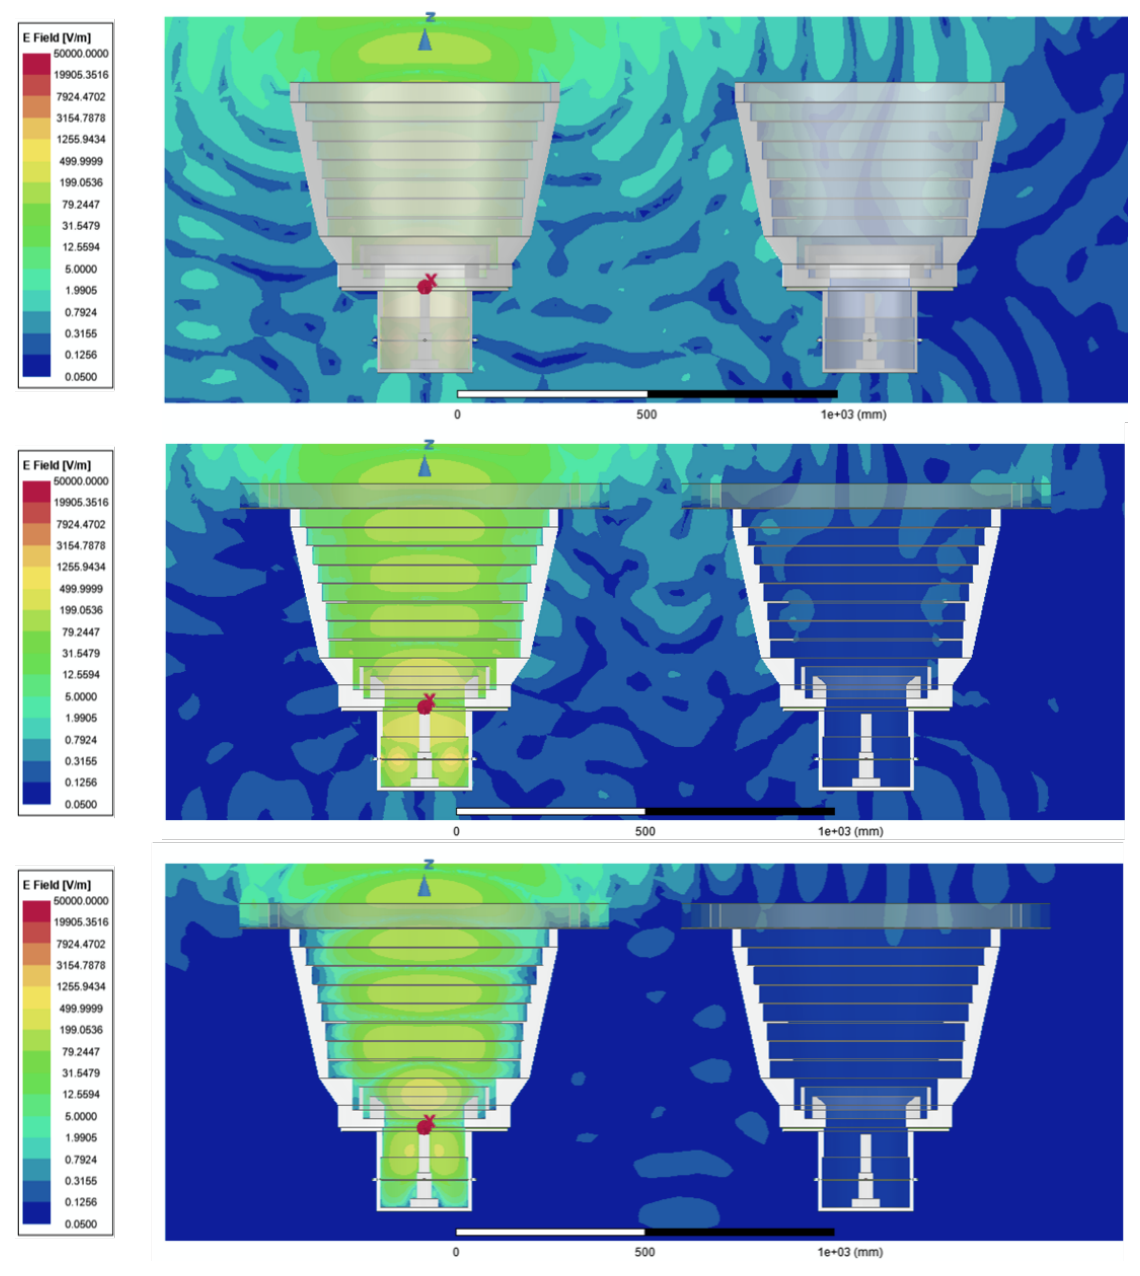
Figure 9. Simulation results obtained with the Ansys HFSS simulation software for the electrical near-field of two VEGA antennas without choke rings (horizontal polarization) ( top ) and with choke rings for horizontal (middle) and vertical polarization ( bottom ) of the transmitting antenna. The simulation was conducted using the finite element–boundary integral (FEBI) method, which is a reflectionless boundary condition and requires no theoretical minimum distance from the radiator. With this approach, the simulation volume, which is shown above, could be reduced without influencing the radiation